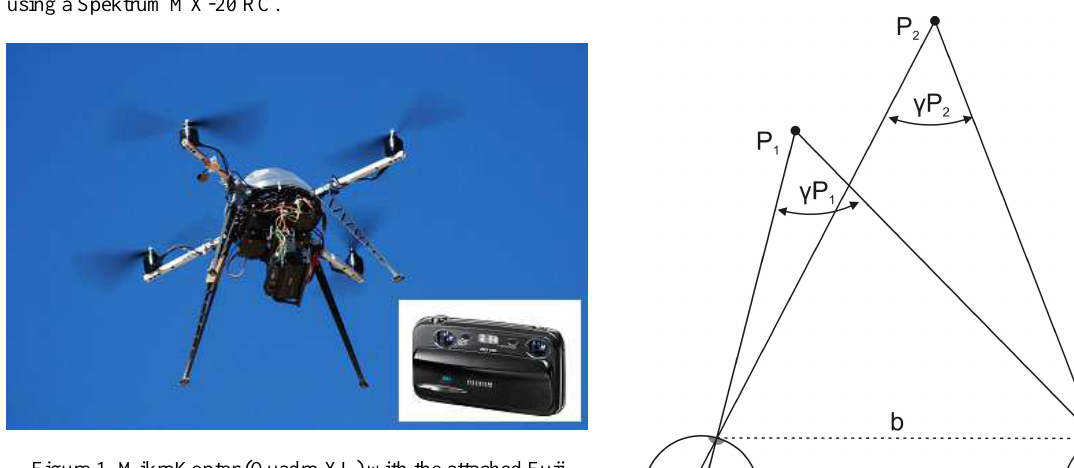
Figure 1. MikroKopter (Quadro XL) with the attached Fuji FinePix Real 3D W3 stereo camera during a flight mission at the survey site Doliche (photo by R. Dylka, 2012)